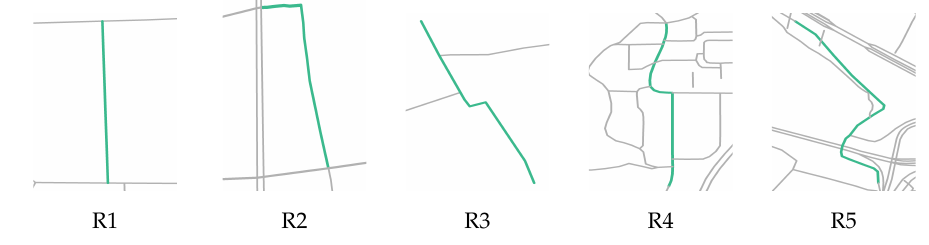
Figure 4. Individual roads extracted from